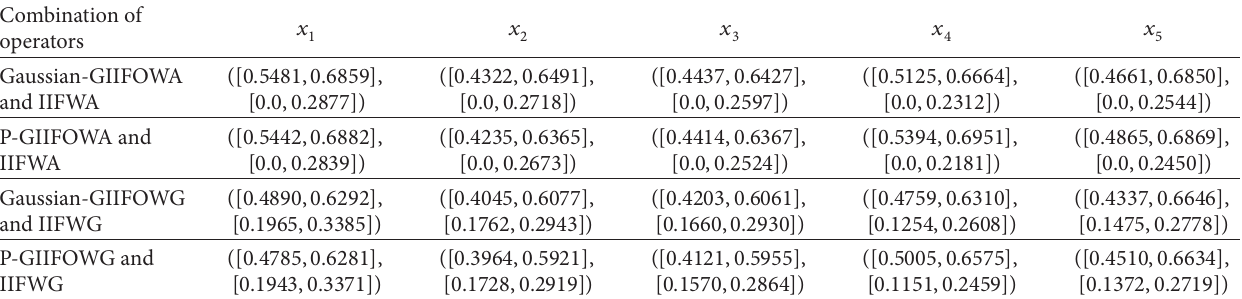
Table 8: Overall group decision assessment values for all alternatives.